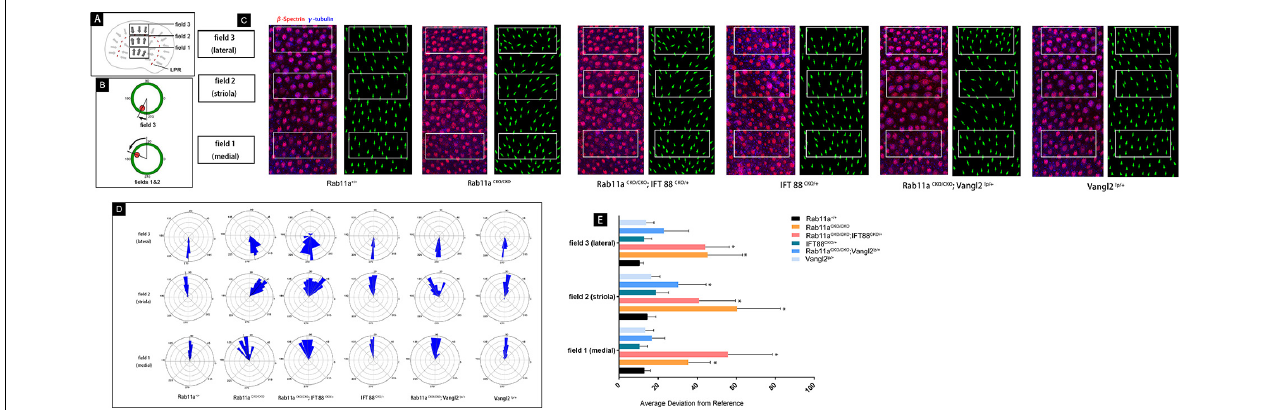
FIGURE 4 | Quantification of vestibular hair cell orientation in control and Rab11a mutant utricles. (A) Schematic illustrating the positions of the three analysis fields relative to the position of the line of polarity reversal (LPR; red dashed line). Hair cells in the maculae are patterned about the LPR, and as a result cells in the lateral extrastriolar region (LES) have stereociliary bundle orientations that are opposite of those in the striola and medial extrastriolar region (MES). (B) Individual stereociliary bundle orientations for vestibular hair cells of the utricular maculae graphed as circular histograms indicated stereociliary bundle misorientation in the striolar region of the Rab11a mutant mice. A 90 ◦ is directed toward the lateral and 180 ◦ toward the medial edge of the utricular maculae, and each bin is 12 ◦ . The total numbers of hair cells represented by each histogram ( n ) are shown, and black bars mark the mean stereociliary bundle orientation. The dimensions of the analysis fields are all 100 mm × 50 mm. (C) Wild-type utricle hair cells labeled for planar polarity analysis with antibodies to γ -tubulin (blue) and β -spectrin (red). The region close to the LPR was selected from each sample. Individual hair cell orientations have been annotated based on the labeling. Utricles from Rab11a CKO / CKO and Rab11a CKO / CKO ; IFT 88 CKO / + mice had misoriented hair cells throughout fields 1–3, while misoriented hair cells in utricles from Rab11a CKO / CKO ; Vangl2 Lp / + mice were restricted to field 2. (D) The average mean deviation of stereocilia bundle orientations was determined by measuring the absolute value of the angle formed by the bundle axis and a reference line drawn perpendicular to the striola. In this schematic, red indicates the position of the kinocilium and green is the